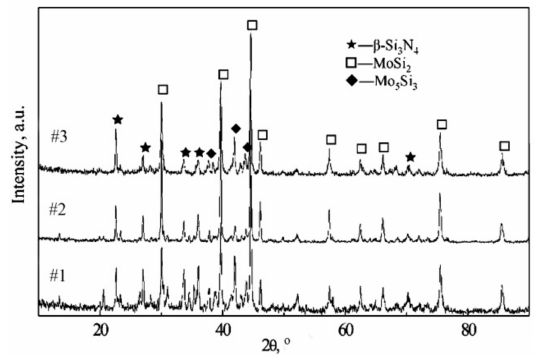
Figure 2. XRD pattern of the Si 3 N 4 –MoSi 2 composites.